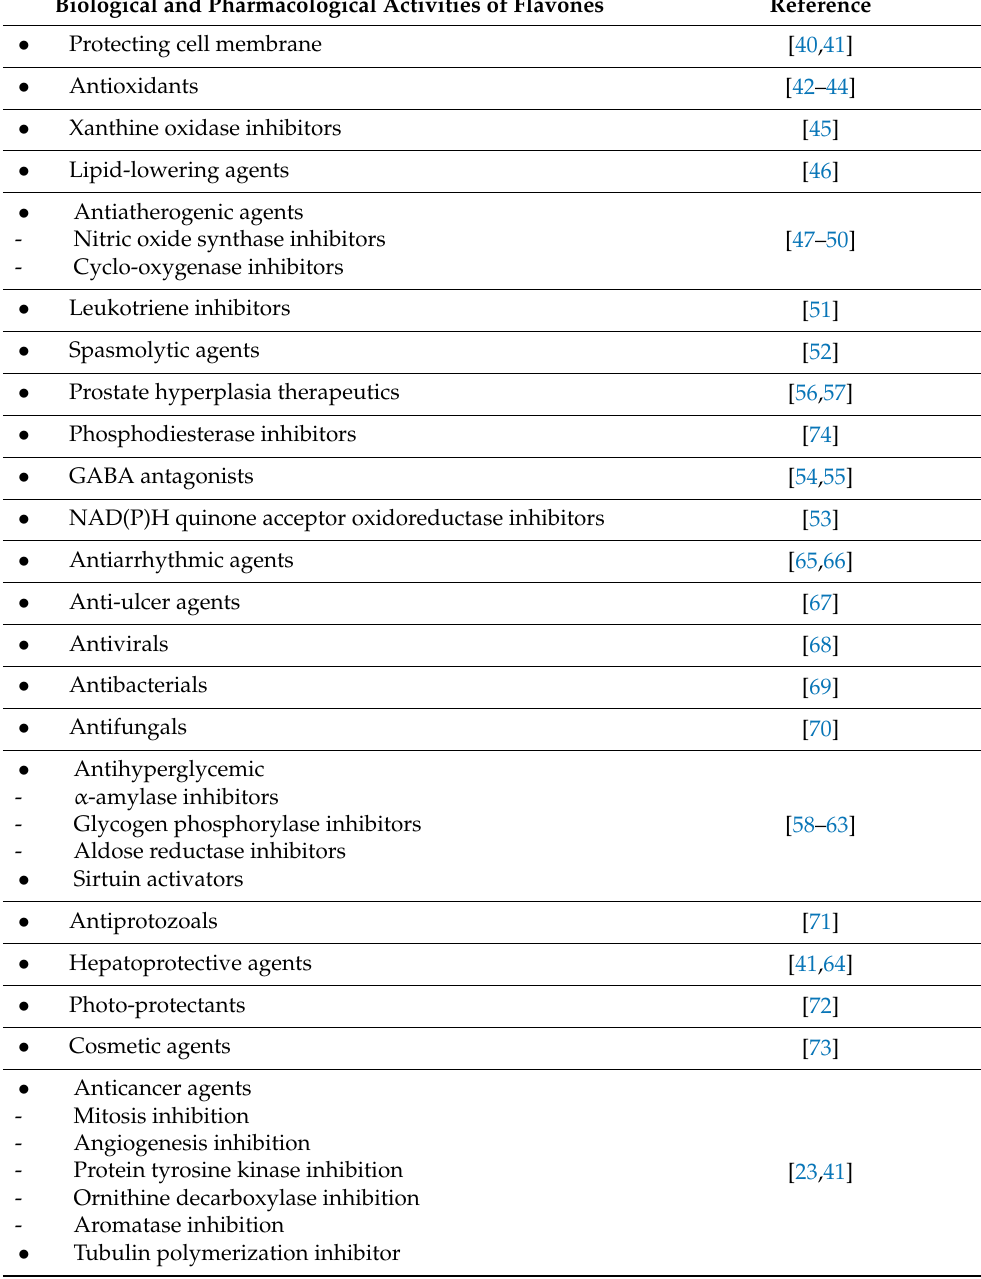
Table 1. Biological and pharmacological activities of flavones. Biological and Pharmacological Activities of Flavones